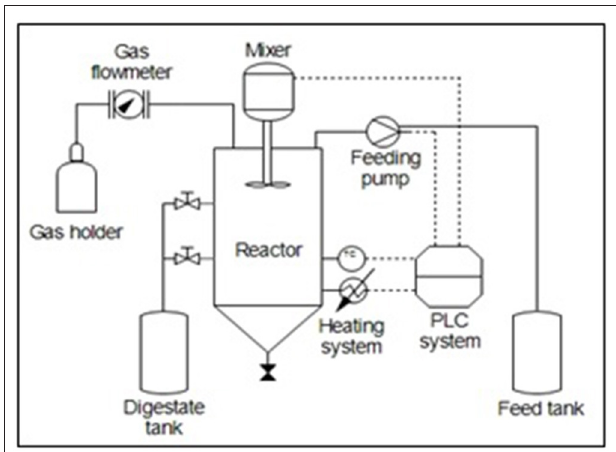
FIGURE 3 | Configuration of the experimental AD/Co-AD